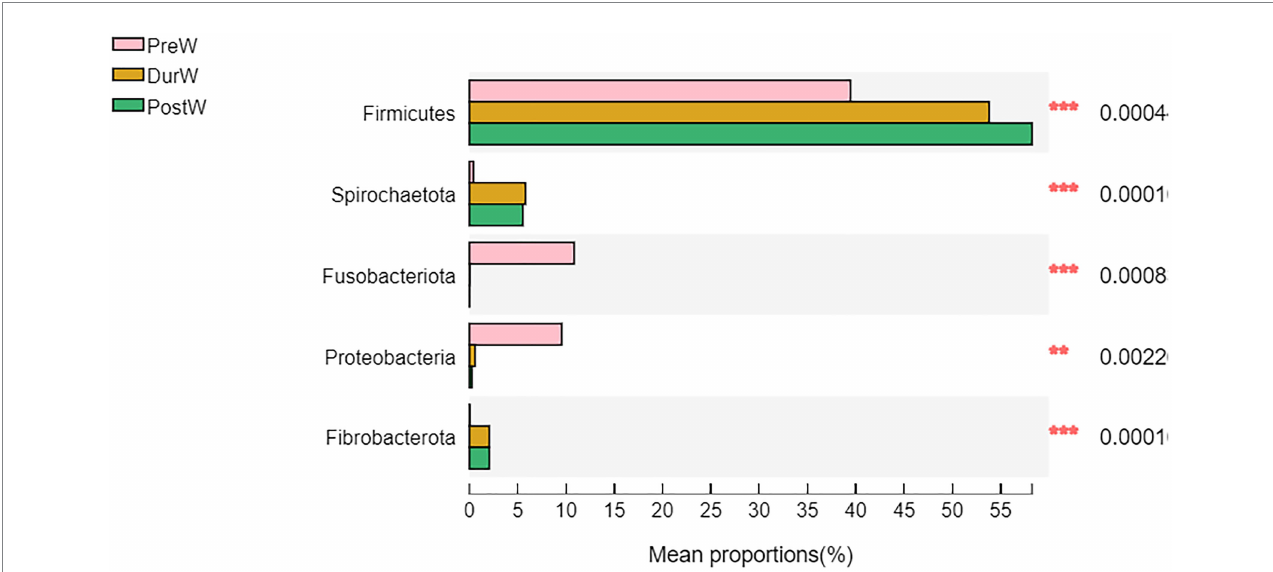
FIGURE 4 Difference of the predominant microbiota at phylum level among different groups (abundance of the microbiota is expressed as a percentage). PreW, pre- weaning donkeys; DurW, during weaning donkeys; PostW, post-weaning donkeys; ** p < 0.05; *** p <